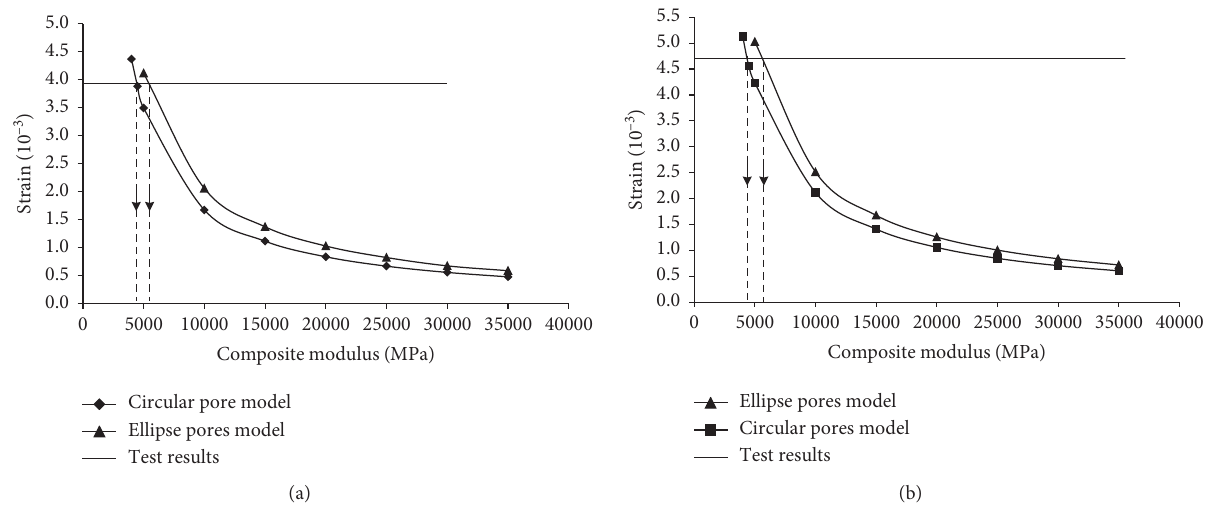
Figure 16: Composite modulus of aggregate-cement paste determination in simulation model: (a) specimen 1#; (b) specimen